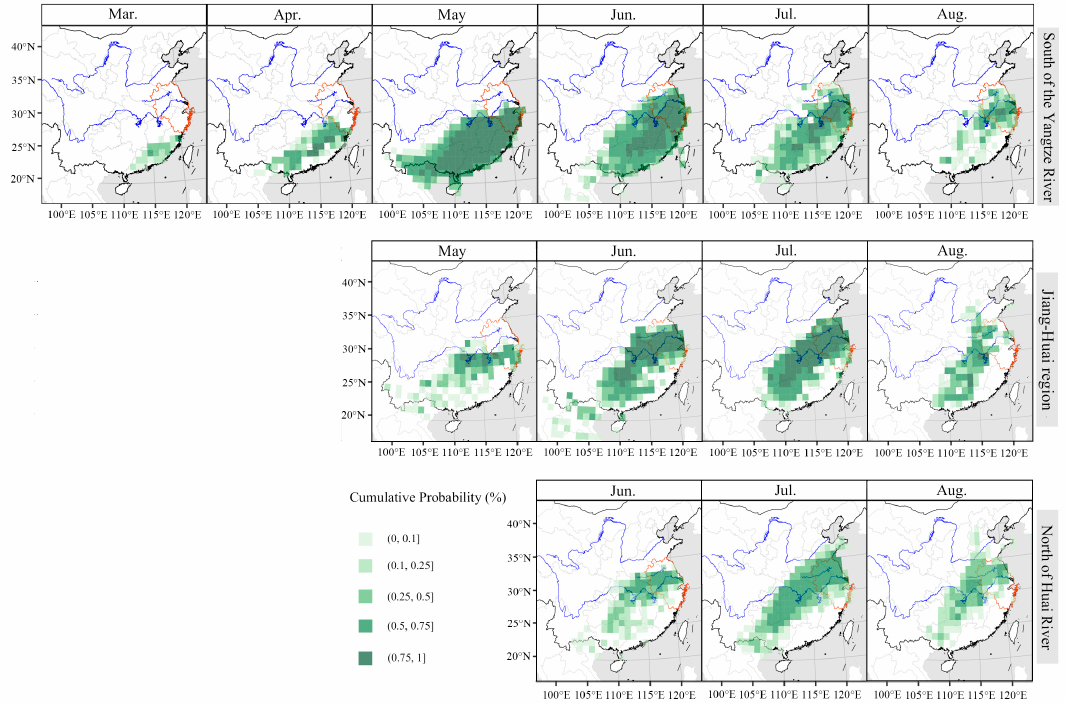
Figure 3. Backward trajectory endpoints distribution of Spodoptera frugiperda in the Yangtze River Delta from 2019 to 2021.